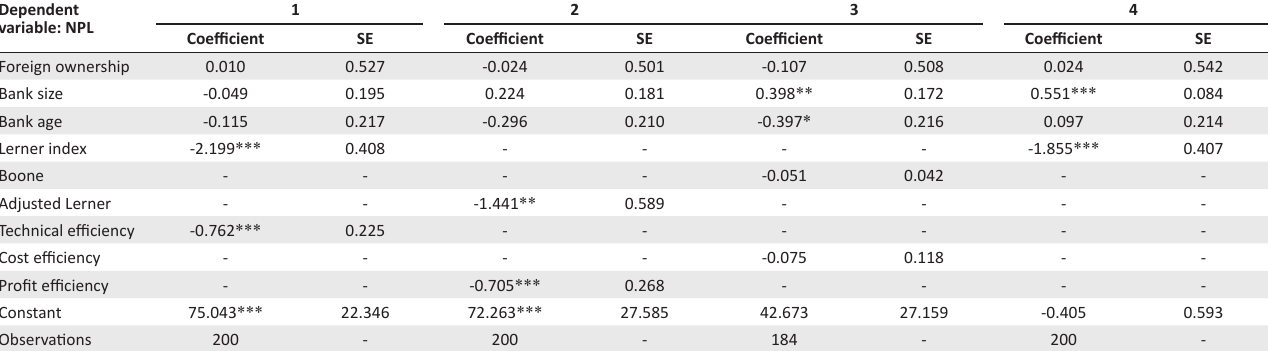
TABLE 3-A1: Bank stability results using non-performing loans. Dependent variable: